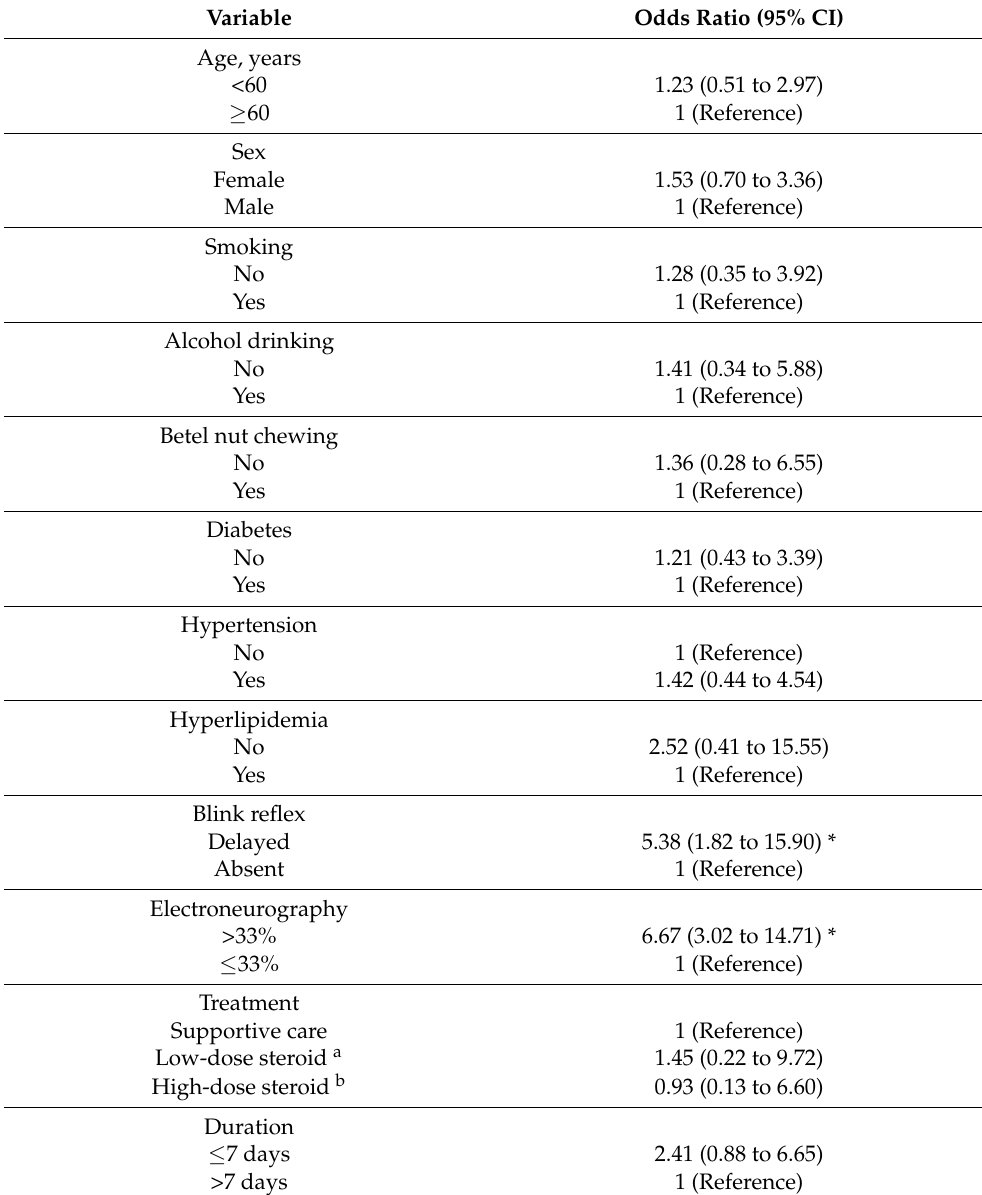
Table 2. Multivariable logistic regression analysis for favorable outcomes in patients with idiopathic Bell’s palsy ( n =